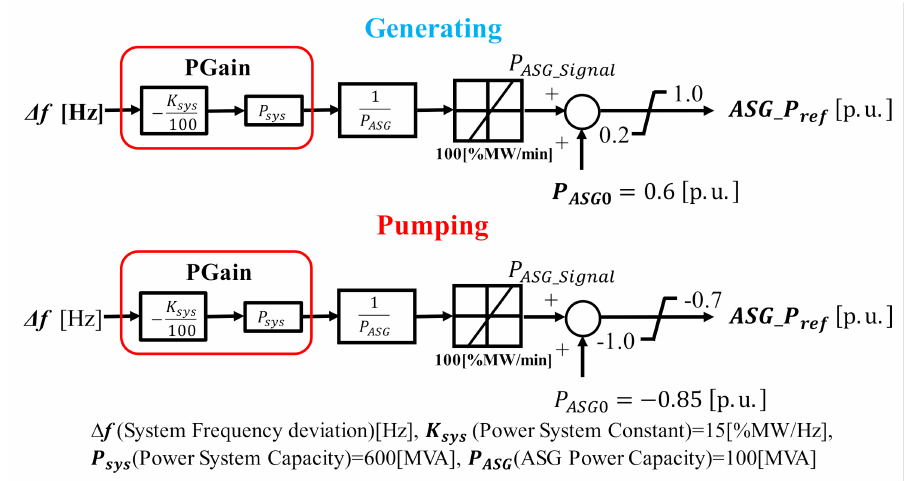
Figure 11. Frequency control systems of the